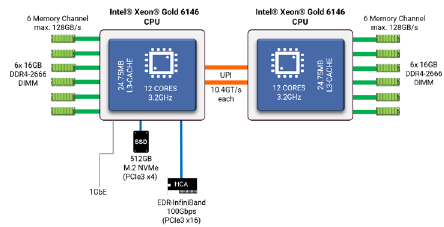
Figure 1: DEEP-EST Prototype CM node